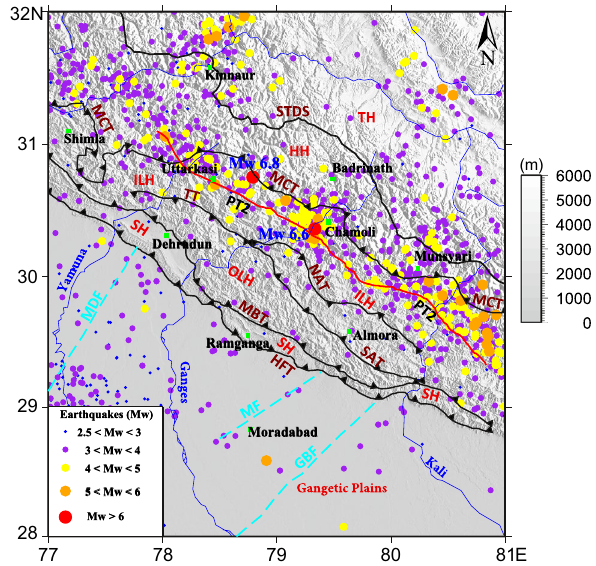
Figure 1. Morphotectonic map of the study area with seismicity. Major plate boundary faults namely Himalayan Frontal Thrust (HFT), Main Boundary Thrust (MBT), Main Central Thrust (MCT), South Tibetan Detachment System (STDS) are marked along with the Mahendragarh–Dehradun Fault (MDF), Moradabad fault (MF), Great Boundary Fault (GBF) and the physiographic transition (PT2). The major morphotectonic zones namely Sub-Himalaya (SH), Outer Lesser Himalaya (OLH), Inner Lesser Himalaya (ILH), Higher Himalaya (HH) and the Tethyan Himalaya (TH) are marked. Colored dots indicate the seismicity of the region with size increasing with magnitude (data from ISC catalog). The basemap is the 3 arc-second elevation from SRTM Digital Elevation Model in greyscale and the map was created by Generic Mapping Tool (GMT)